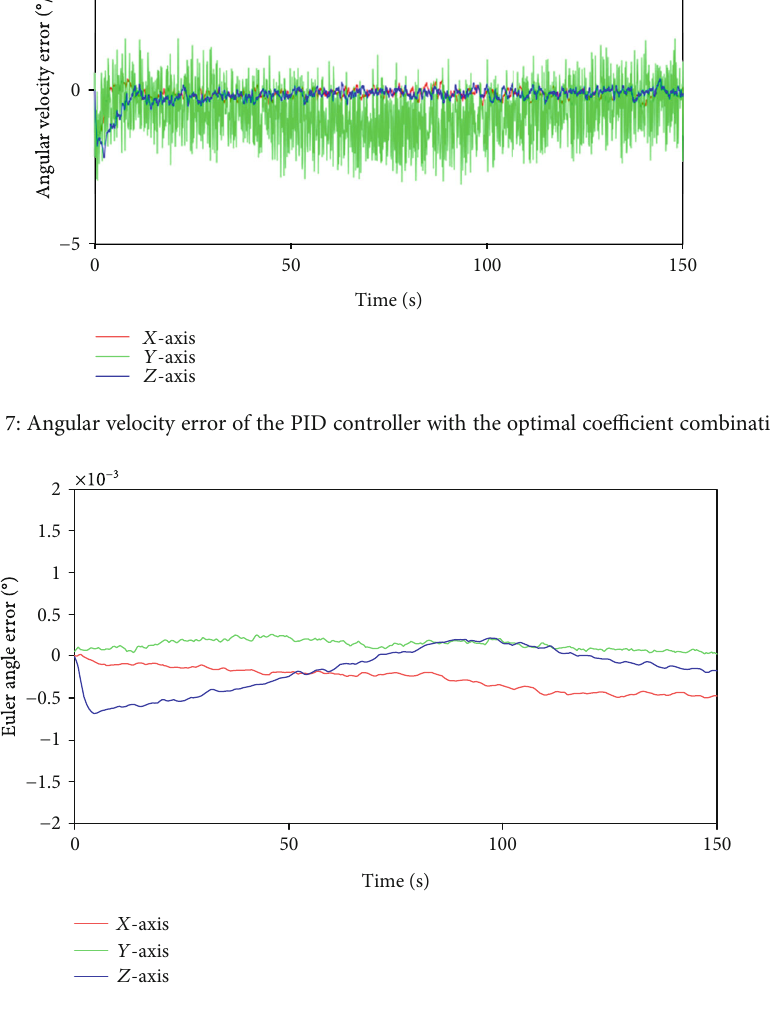
Figure 8: Euler angle error under the control of neural